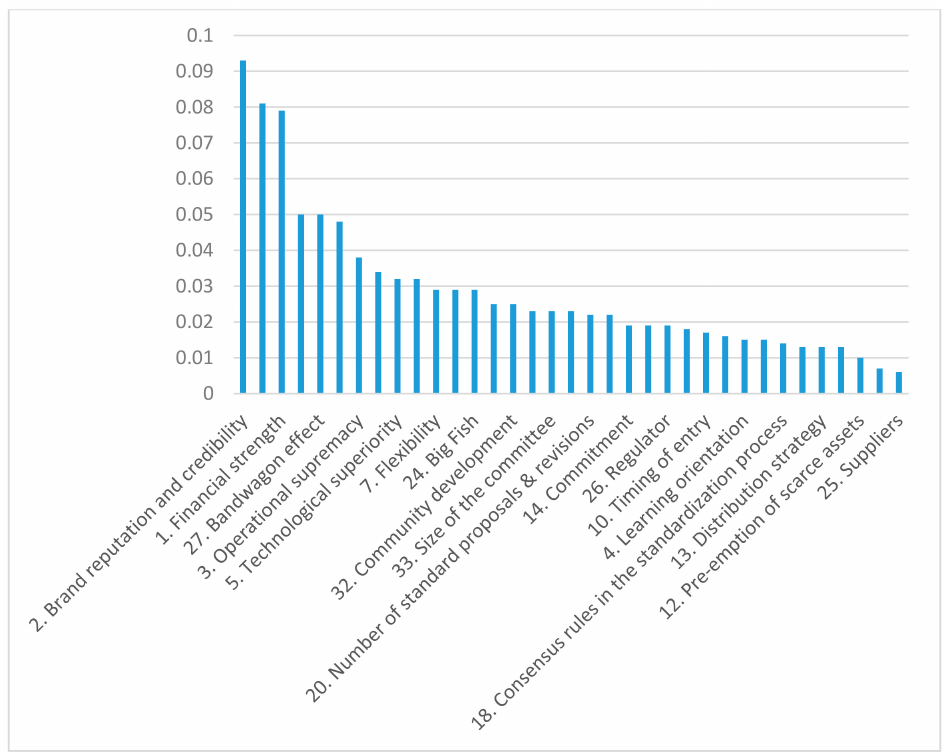
Figure 2. A visualization of the results ranking the factors from most important to least